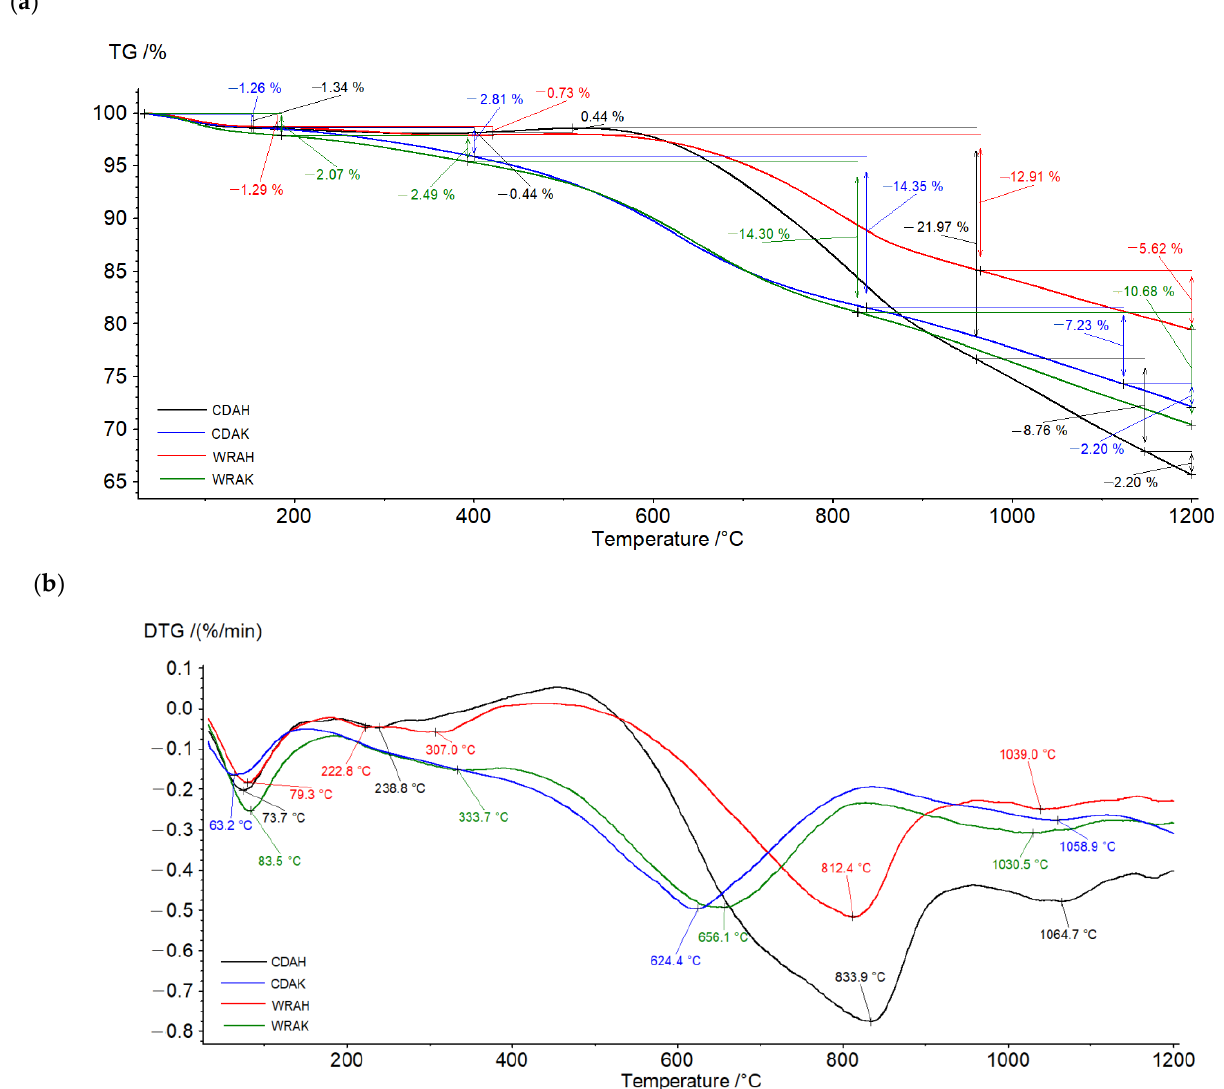
Figure 4. TG ( a ) and DTG ( b ) curves of the activated carbons obtained in the helium atmosphere.